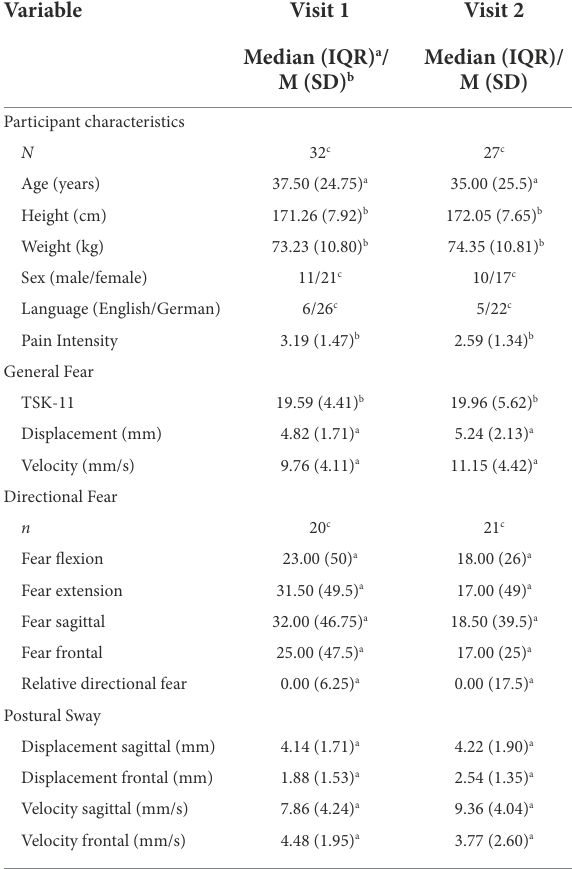
TABLE 1 Descriptive statistics of participant characteristics, fear assessments and postural sway outcomes at both assessment